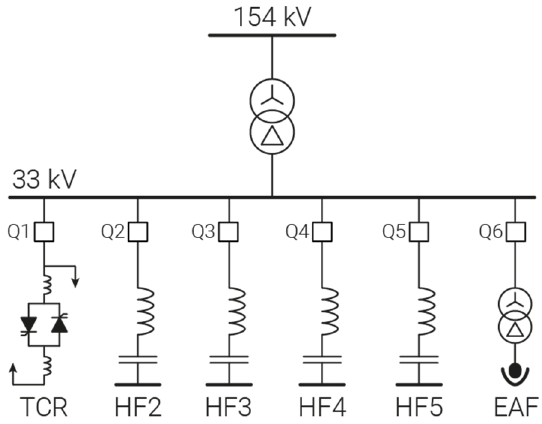
Figure 2. Configuration of an electric arc furnace with four single-tuned filter banks.